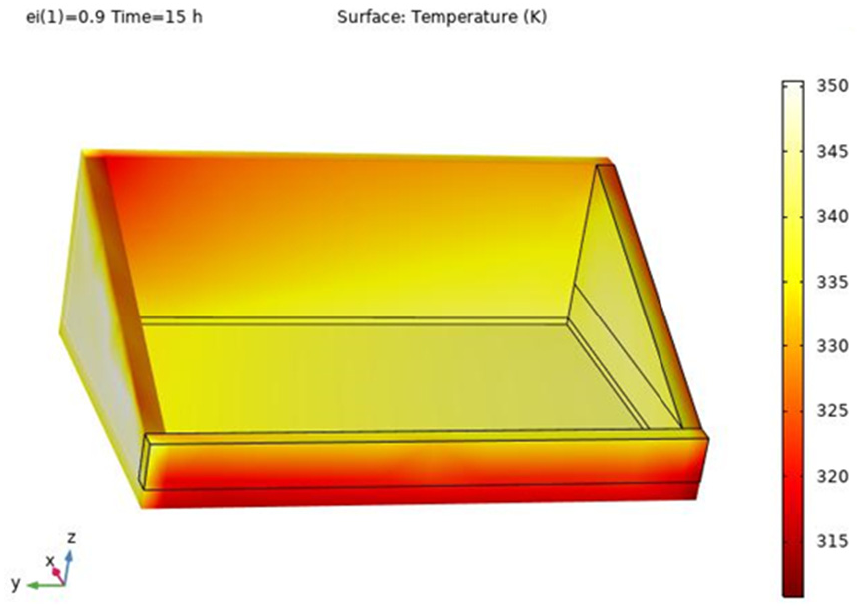
Figure 6. Temperature variation (in K) on walls of the solar still (simulation time = 3 PM).